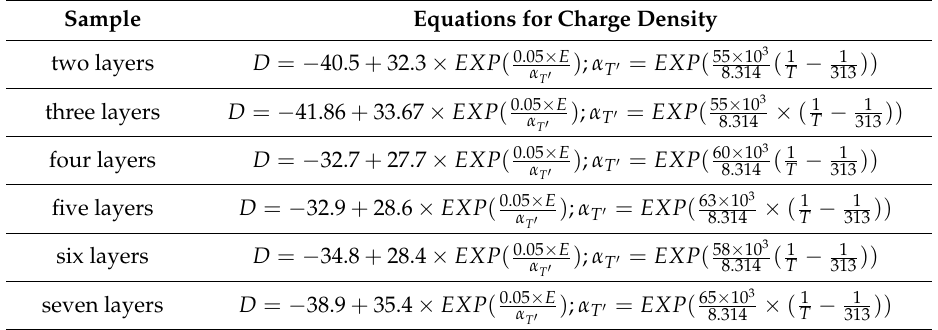
Figure 13. Interface charge density absolute values at steady state under different electrical field strengths with different temperatures for multi-layer oil-paper insulation. Table 6. Calculation equations for the charge density under the combined action of electrical field strength and temperature for multi-layer oil-paper insulation.